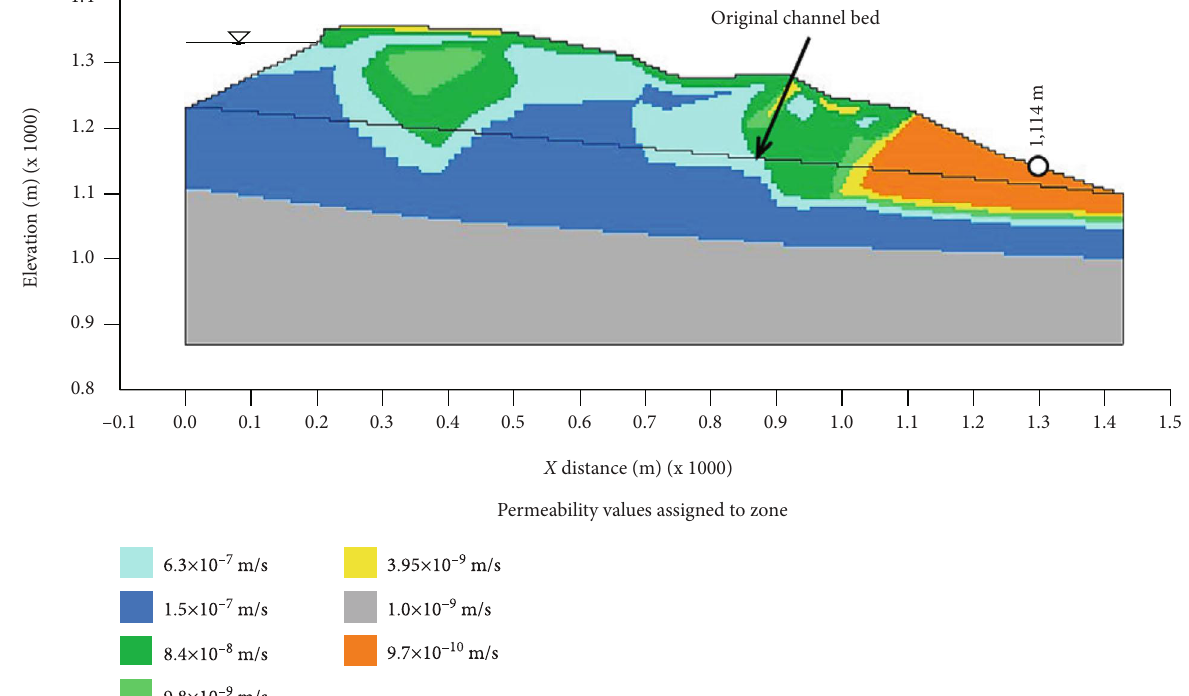
Figure 17: Finite element model used in SEEP/W for seepage analyses of the landslide dam section along the longitudinal survey line.